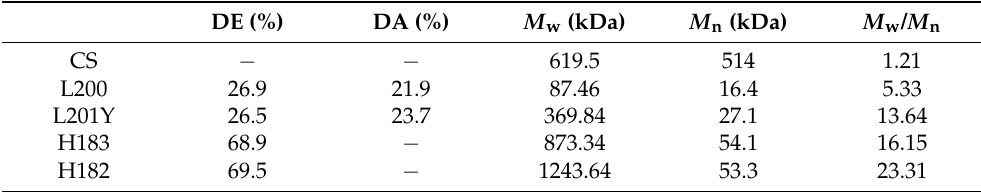
Table 1. Degree of esterification and amidation, weight average molecular weights, and number average molecular weights values of the CS and